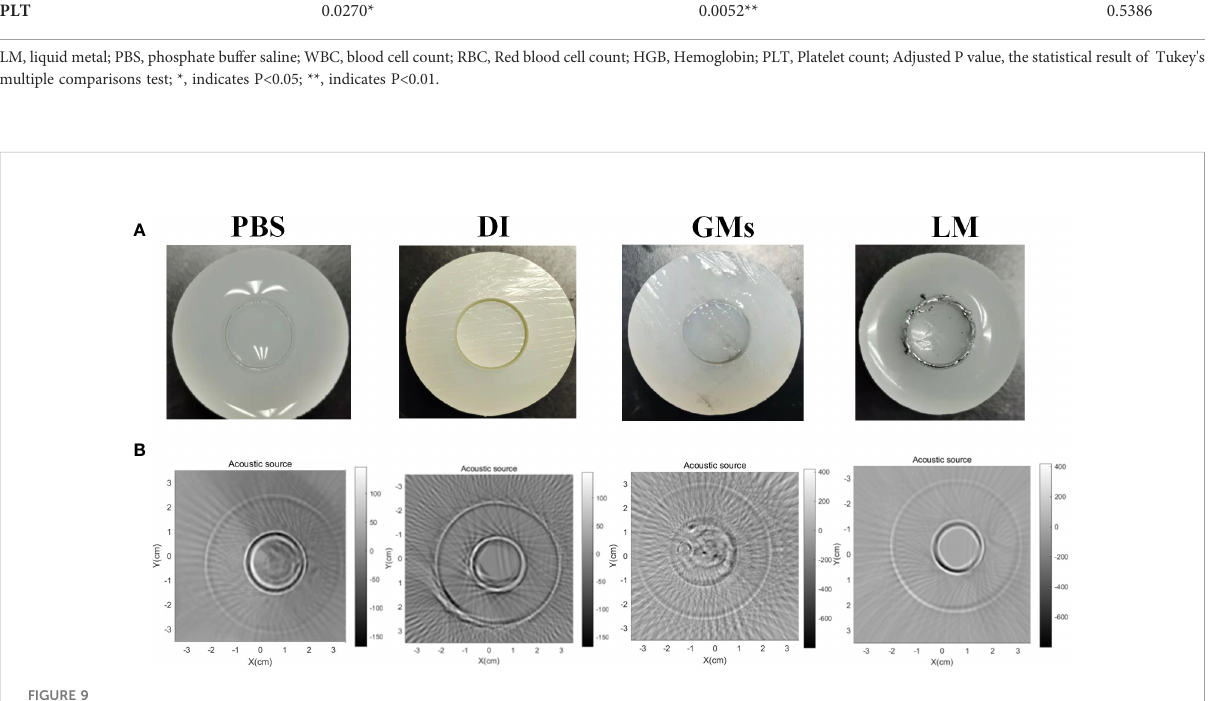
FIGURE 9 The cylindrical agar-body with different fi ll materials and correspondent MAT images. (A) PBS, DI, Gallium micropaticels(GMs), LM fi lled the 1mm clearance of cylindrical agar-body. (B) The correspondent MAT images of cylindrical agar-body with various materials. PBS, phosphate buffer saline; DI, Deionized water; GMs, Gallium-based ally microparticles; LM, liquid